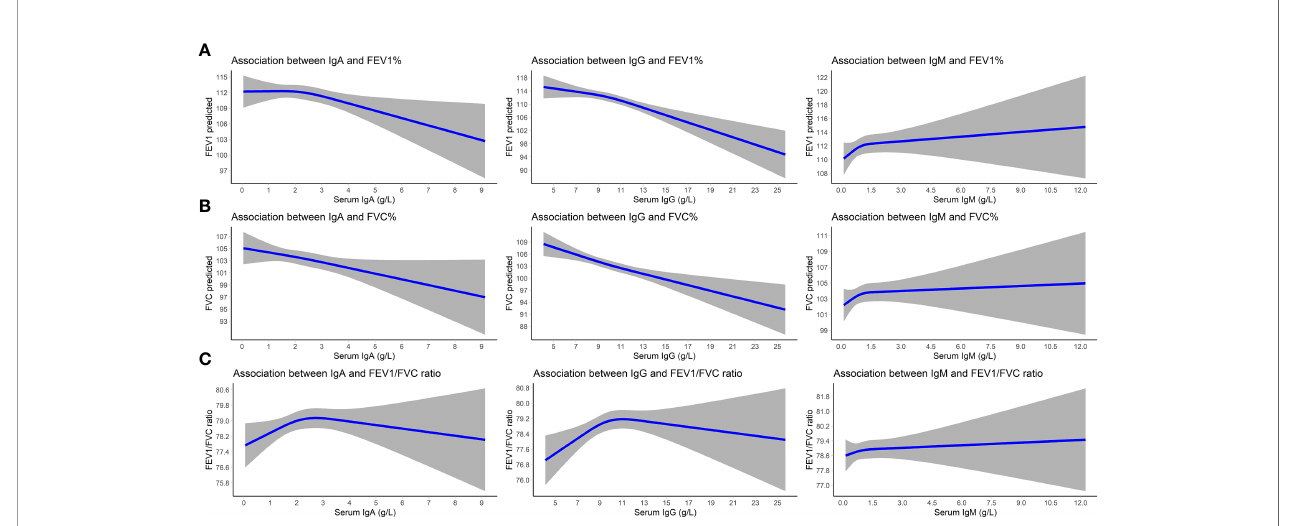
FIGURE 2 | Association between serum immunoglobulins and lung function. Displayed are betas (lines) and 95% CIs (gray areas) for the associations of immunoglobulins with FEV 1 predicted (A) , FVC predicted (B) , and the FEV 1 /FVC ratio (C) . Betas are adjusted for age, sex, time interval between blood drawing and spirometry, smoking status, and pack years. IgA/IgG/IgM, immunoglobulin A/G/M; 95% CI, 95% con fi dence interval; FEV 1 , forced expiratory volume in one second; FVC, forced vital